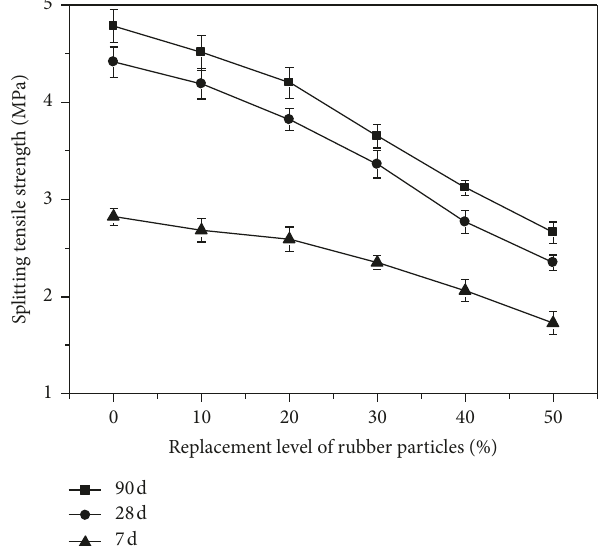
Figure 22: Splitting tensile strength of SCRLC versus replacement level of rubber